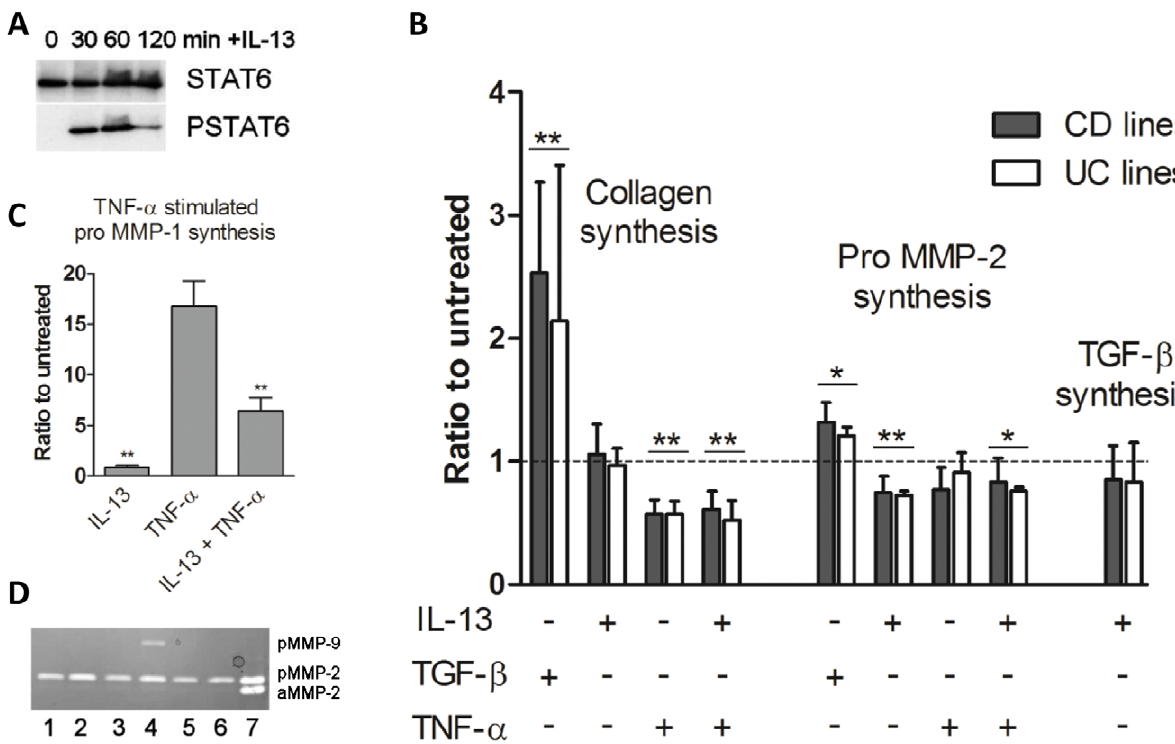
Figure 9. TGF- b drives co-ordinate collagen synthesis and pro-MMP-2 synthesis in intestinal muscle fibroblasts, whereas IL-13 has no effect on collagen synthesis and suppresses proMMP-2, in lines derived from uninvolved CD or UC tissue. (A) Western blots showing phosphorylation of STAT6 by primary fibroblasts in response to exogenous IL-13. Representative blot from 6 experiments. (B) Effect of IL-13, TNF- a and/or TGF- b on collagen, MMP-2 or TGF- b synthesis in primary fibroblasts, Data represent the mean + SEM of the ratio of treated to untreated cultures from a minimum of 8 separate experiments. *p , 0.05, **p , 0.01 compared to untreated cultures. (C) Effect of IL-13 and/or TNF- a on pro- MMP-1 synthesis. Data represent the mean + SEM of the ratio of treated to untreated cultures from 8 separate experiments. **p , 0.01 IL-13 + TNF- a compared to TNF- a - or IL-13-stimulated cultures. (D) Zymogram showing the effect of IL-13, TNF- a and/or TGF- b on MMP-2 and MMP-9 synthesis (pMMP=pro MMP, aMMP=active MMP) (lane 1, untreated; lane 2, TGF- b ; lane 3, IL-13; lane 4, TNF- a lane 5, TNF- a + IL-13; lane 6, TGF- b + IL-13; lane 7, MMP-2 standard).